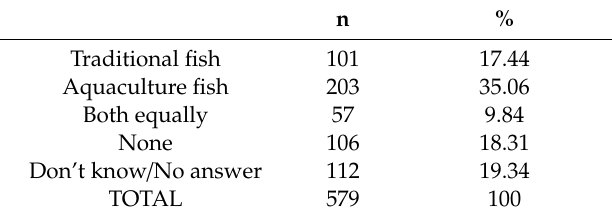
Table 6. Perception of support by public administrations.